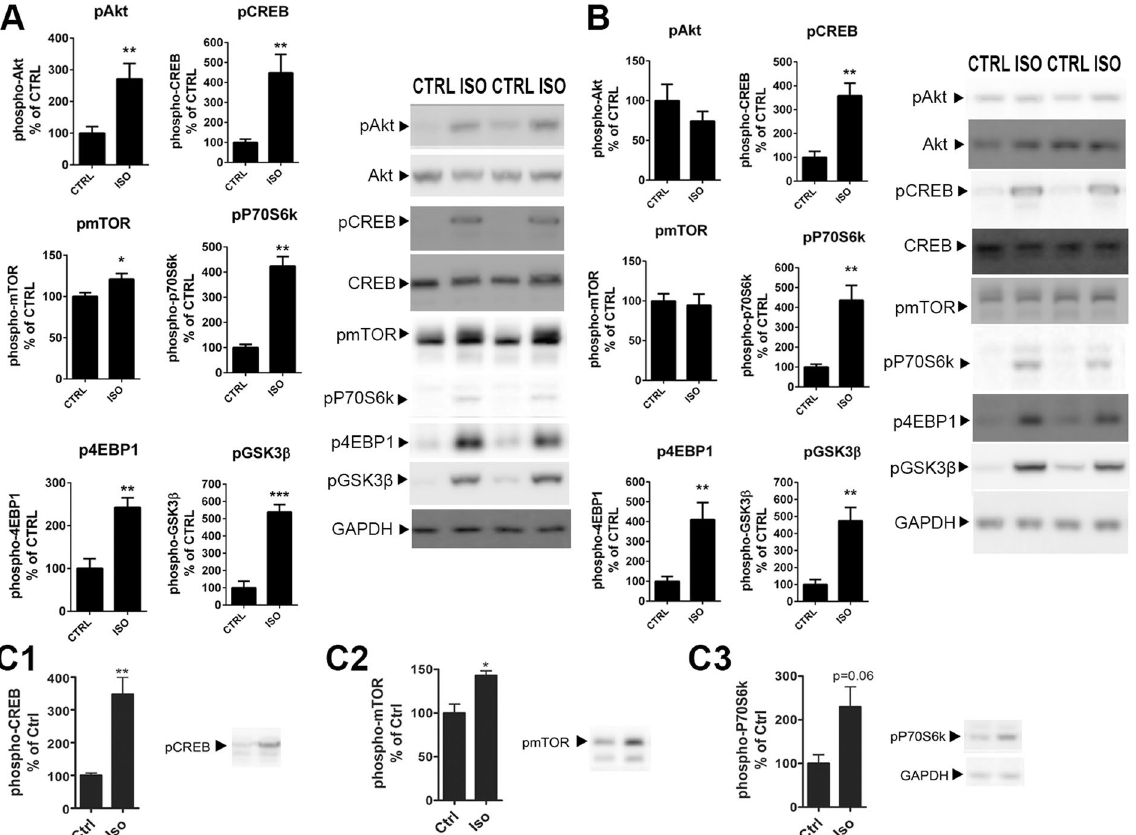
Figure 3. Isoflurane anesthesia regulates intracellular signaling implicated in rapid antidepressant actions. ( A ) Phosphorylation of Akt T308 (p = 0.0084), CREB S133 (p = 0.0087), mTOR S2481 (p = 0.0292), p70S6K T421/S424 (p = 0.0022), 4-EBP1 T37/46 (p = 0.0012) and GSK3 β S9 (p = 0.0001) in the adult mouse prefrontal cortex after isoflurane anesthesia (30 min). ( B ) Phosphorylation of Akt T308 (p = 0.3052), CREB S133 (p = 0.0014), mTOR S2481 (p = 0.7422), p70S6K T421/S424 (p = 0.0022) 4E-BP1 T37/46 (p = 0.0022) and GSK3 β S9 (p = 0.0001) in the adult mouse hippocampus after isoflurane anesthesia (30 min). ( C ) Phosphorylation of CREB S133 , mTOR S2481 and p70S6K T421/S424 are increased within 2 minutes from the onset of isoflurane (4%) administration. pAKT and pCREB levels normalized to corresponding total protein, other phosphoproteins normalized to GAPDH. n = 6/ group. Representative western blots have been cropped from complete immunoblots shown in Supplementary Information file. * p < 0.05, ** p < 0.01, *** p < 0.001; Student’s t test. Abbreviations: CTRL, control treatment; ISO, isoflurane treatment; CREB, cAMP response element binding protein; Akt, protein kinase B; mTOR, mammalian target of rapamycin; GAPDH, glyceraldehyde 3-phosphate dehydrogenase, GSK3 β , glycogen synthase kinase 3 β